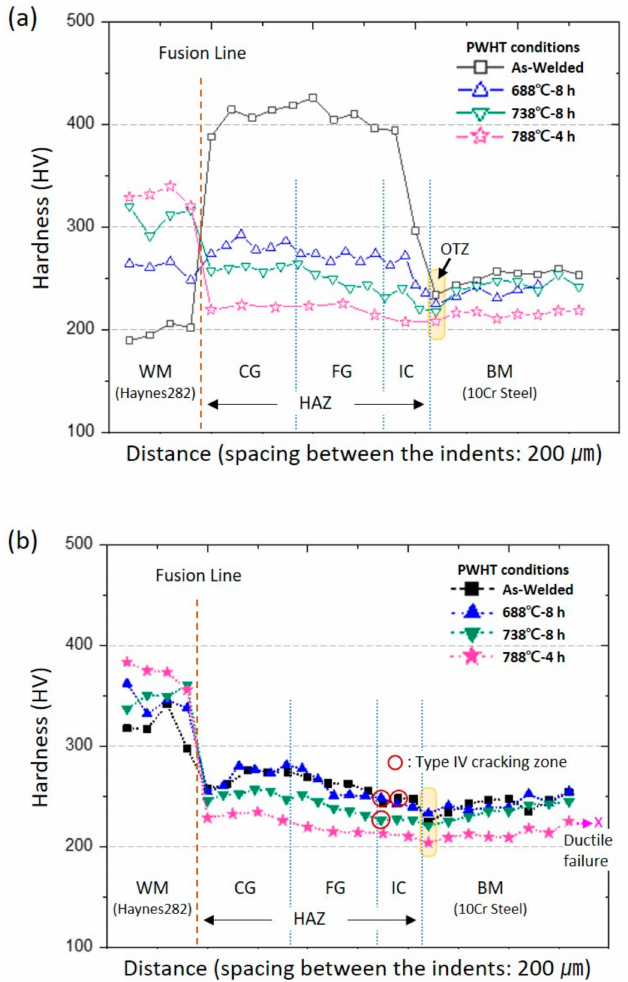
Figure 4. Hardness profile near the weld interface before and after creep test at 600 ◦ C/200 MPa: ( a ) before creep test and ( b ) after creep